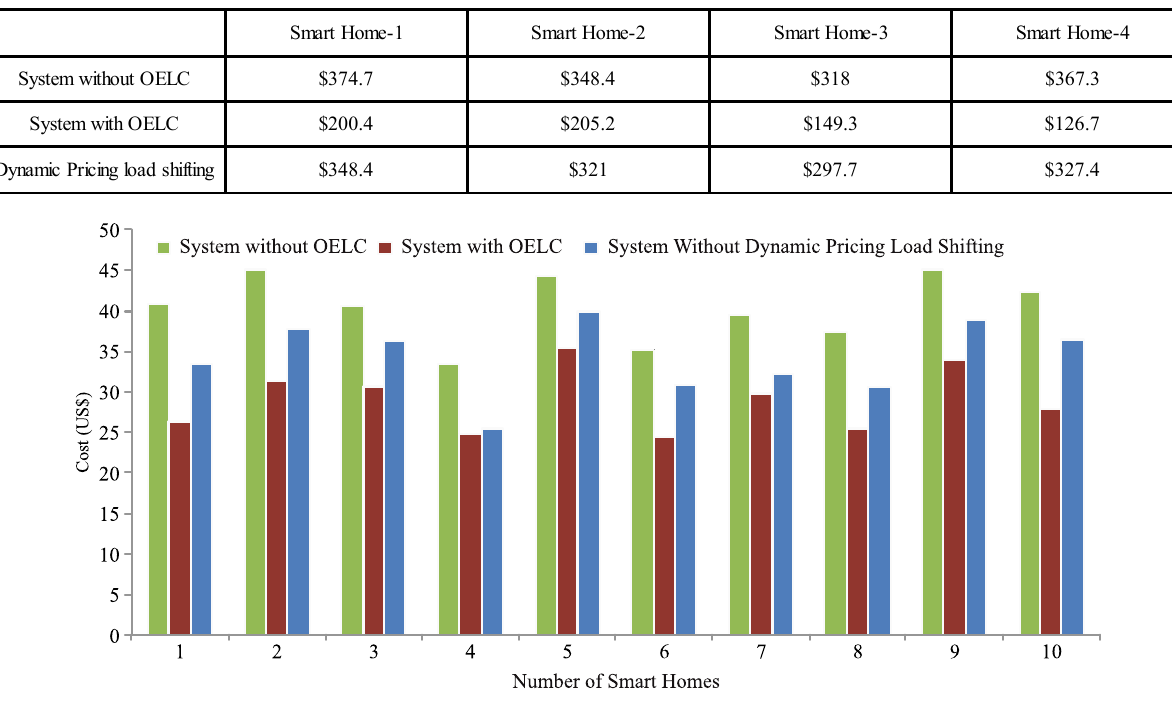
FIG. 6. COMPARISON OF ELECTRICITY COST OF DIFFERENT NUMBER OF SMART HOME USERS USING PROPOSED MECHANISM